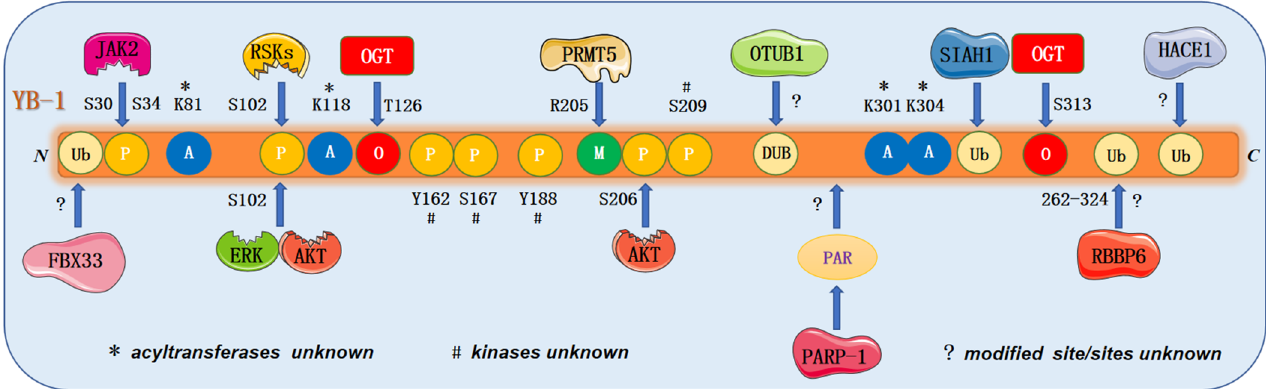
Figure 4. Post-translational modifications of the YB-1 protein. YB-1 is regulated by a variety of post-translational modifications, including phosphorylation (P), methylation (Me), acetylation (Ac), ubiquitination (Ub), O-glycosylation (OGT) and PARyation (PAR). The enzymes and sites modifying YB-1 are labeled.